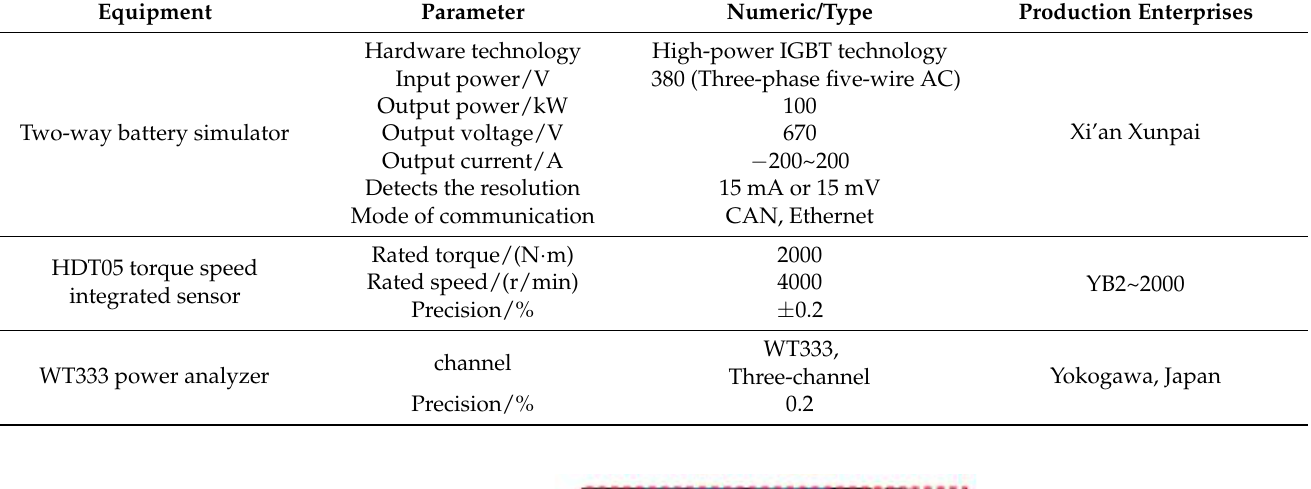
Table 2. Hardware device parameters.